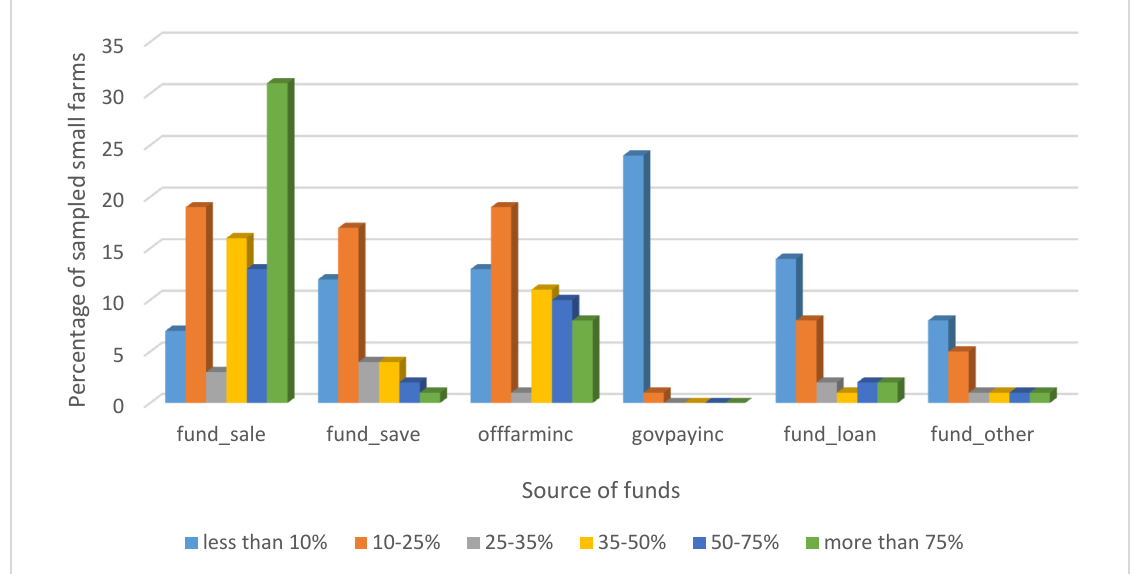
Figure 1. Different sources of financing and the extent of use to meet agricultural expenses by small farmers in Tennessee.